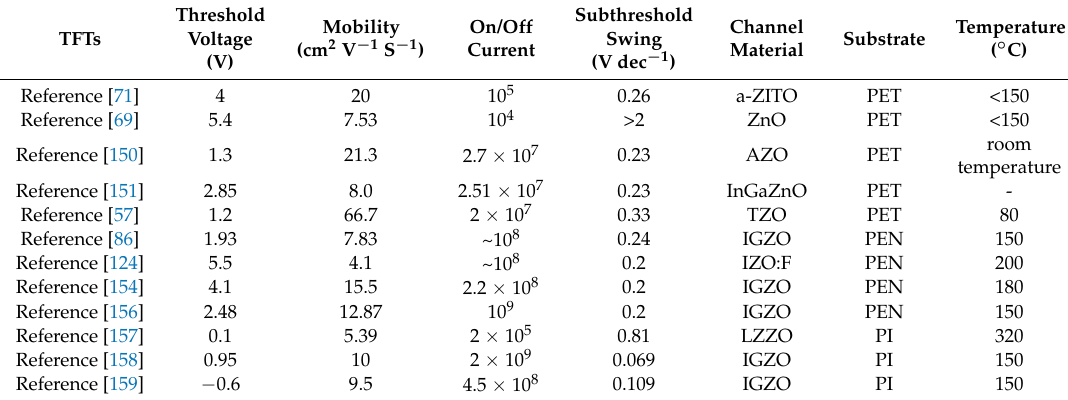
Table 1. Summarized performances for representative flexible oxide-based